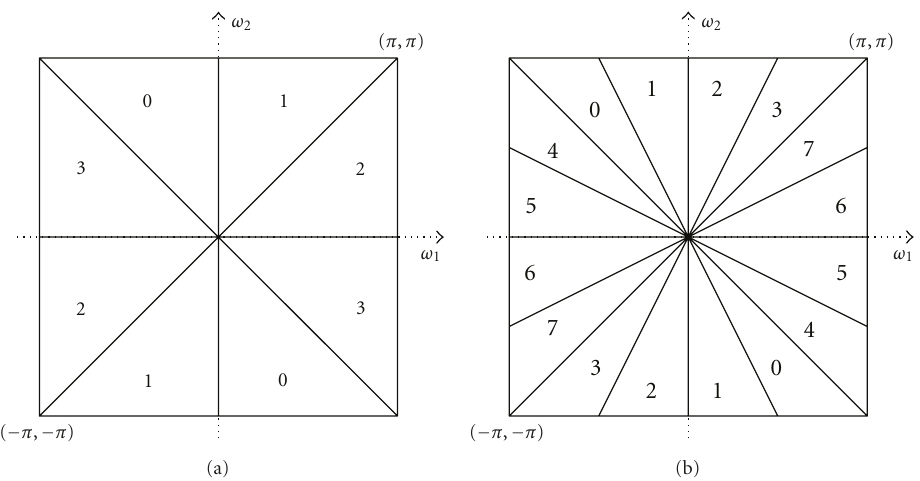
Figure 1: Frequency divisions of the conventional DFB [7] in case of (a) four-channel DFB and (b) eight-channel DFB.